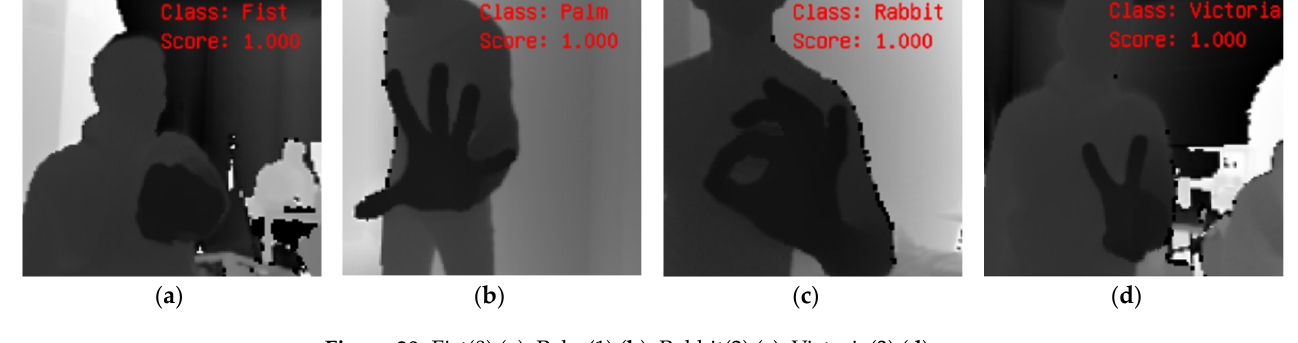
Figure 20. Fist(0) ( a ), Palm(1) ( b ), Rabbit(2) ( c ), Victoria(3) ( d ). Table 4. 3D CNN classifiers